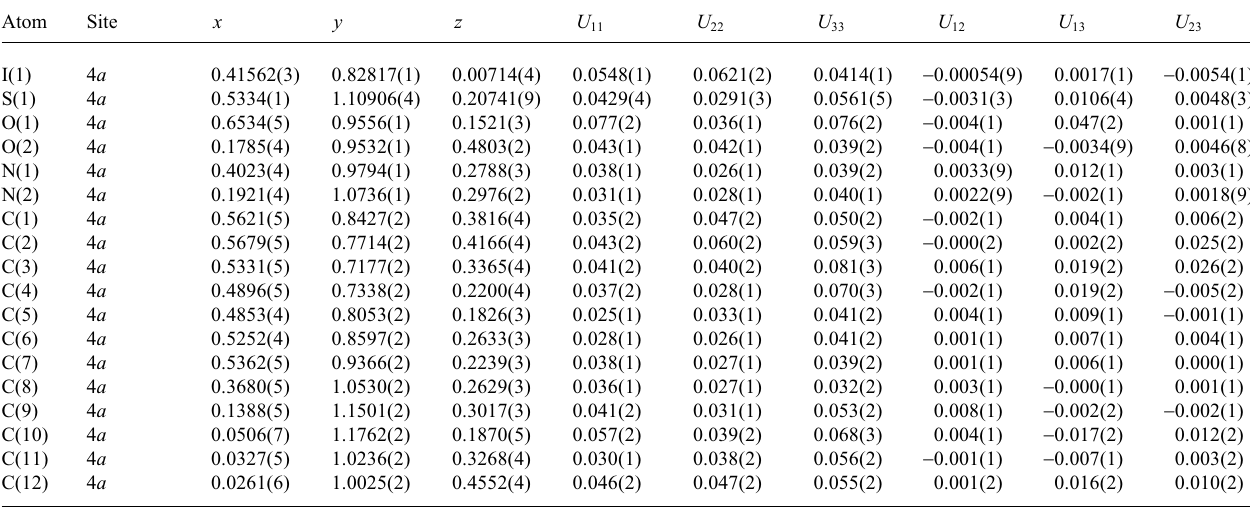
Table 3. Atomic coordinates and displacement parameters (in Å 2 )